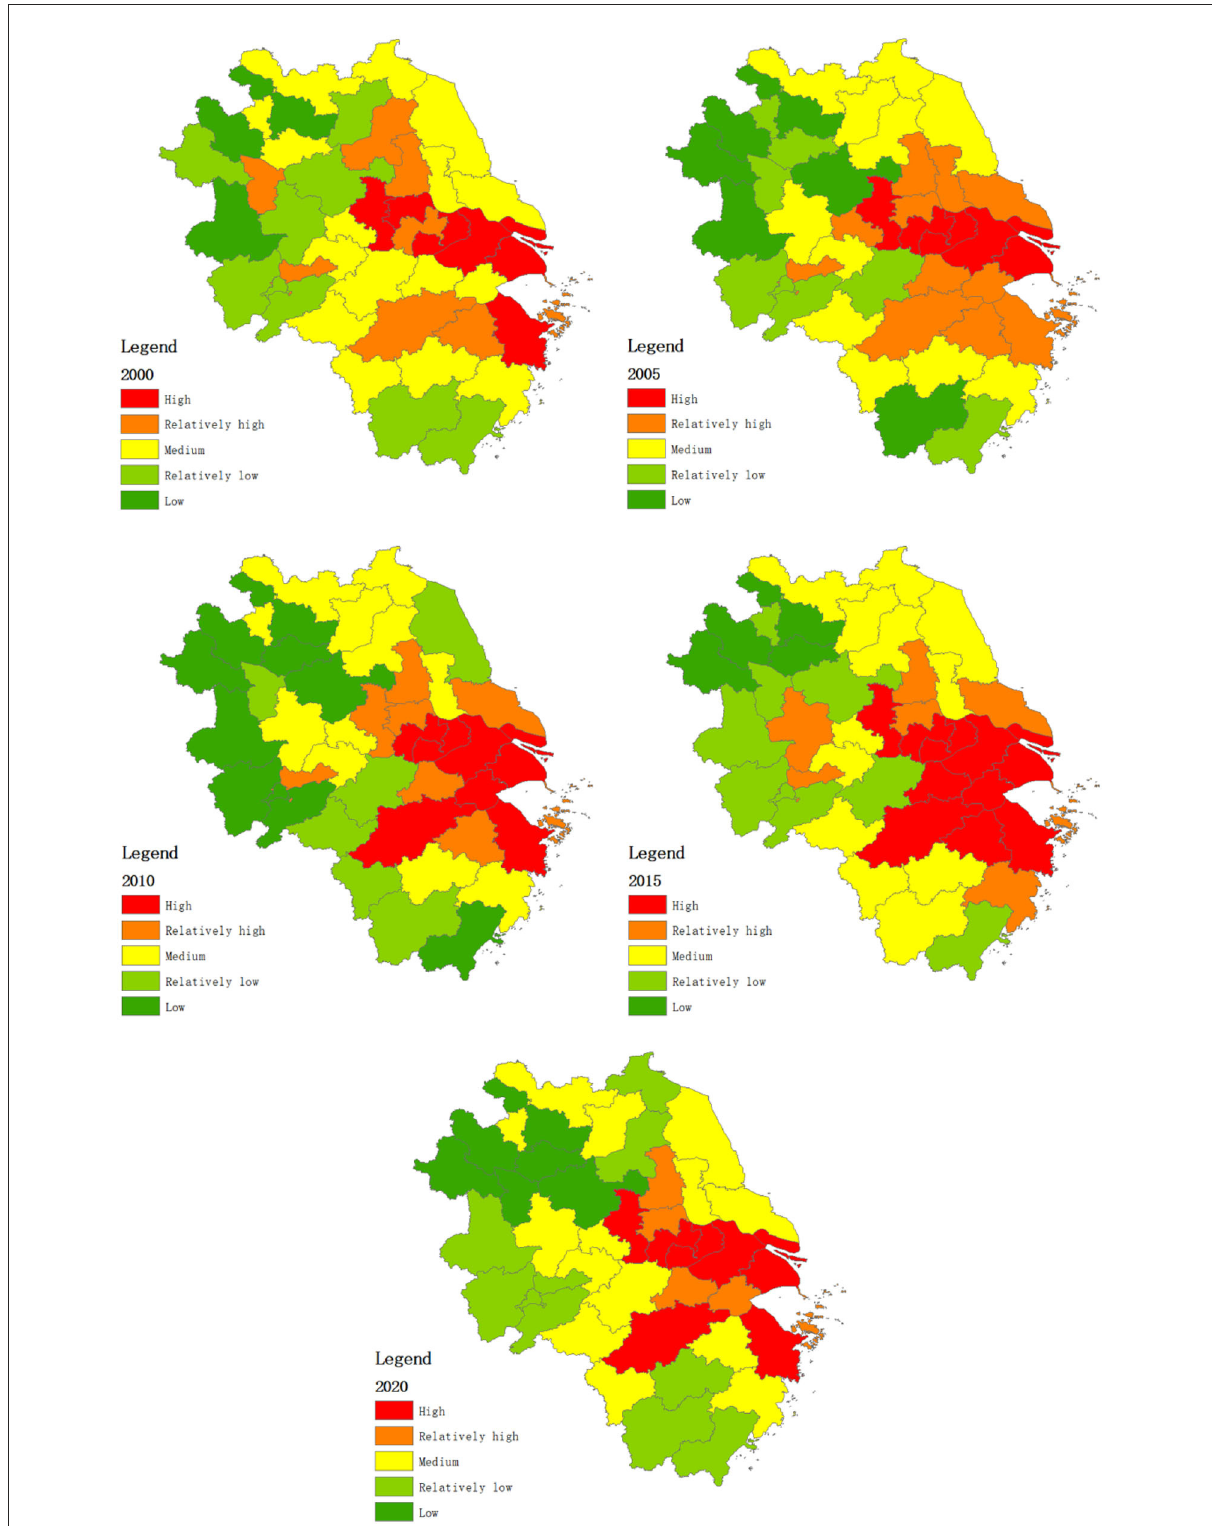
FIGURE3 Distribution of integrated development level in 41 cities of Yangtze River